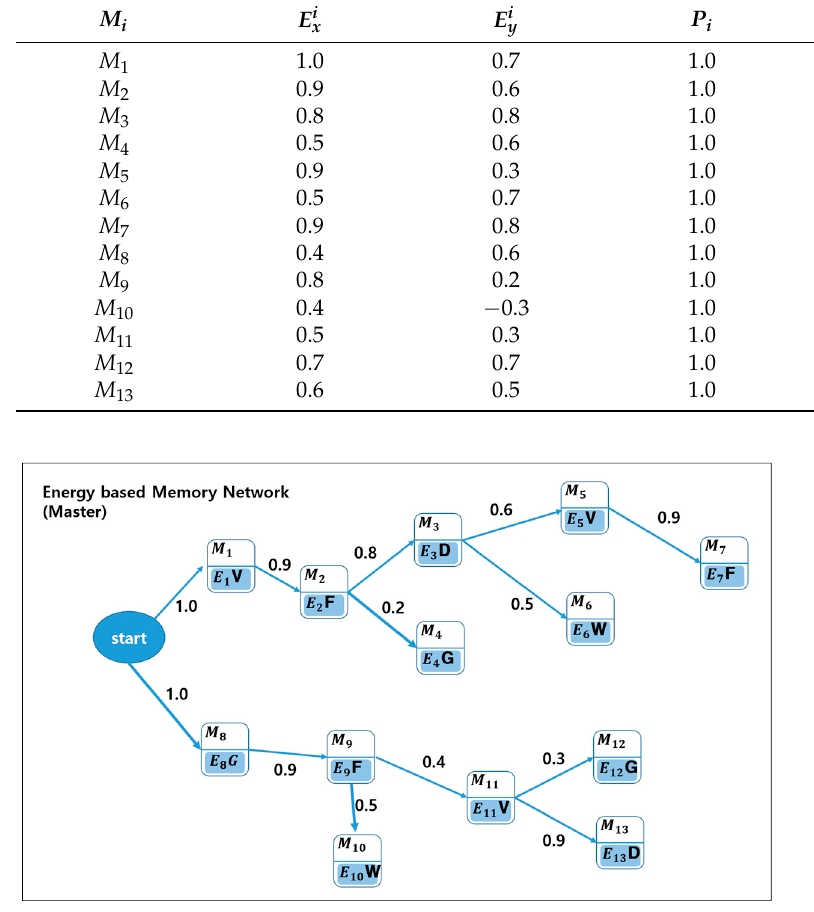
Figure 12. Master Energy-based Memory Network. Table 2. Memory Capsule list : Memory ID, Energy value, 𝑷 𝒊 (Probability of Self) , 𝑸 𝒊 (Qualia) 𝑴 𝒊 𝑬 𝒙𝒊 𝑬 𝒚𝒊 𝑷 𝒊